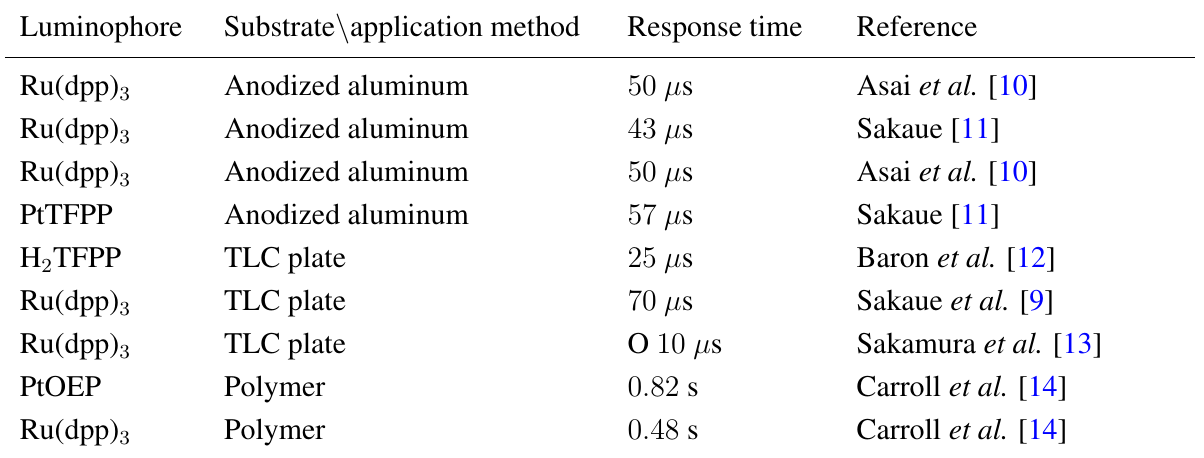
Table 1. Typical PSP response